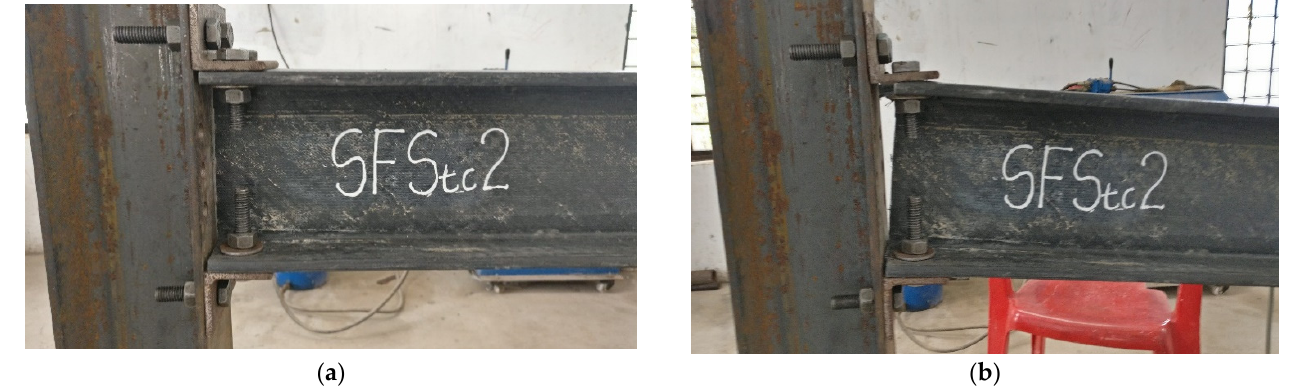
Figure 14. Shear-out failure in specimen SFSct2: ( a ) Undeformed joint; ( b ) Deformed joint.